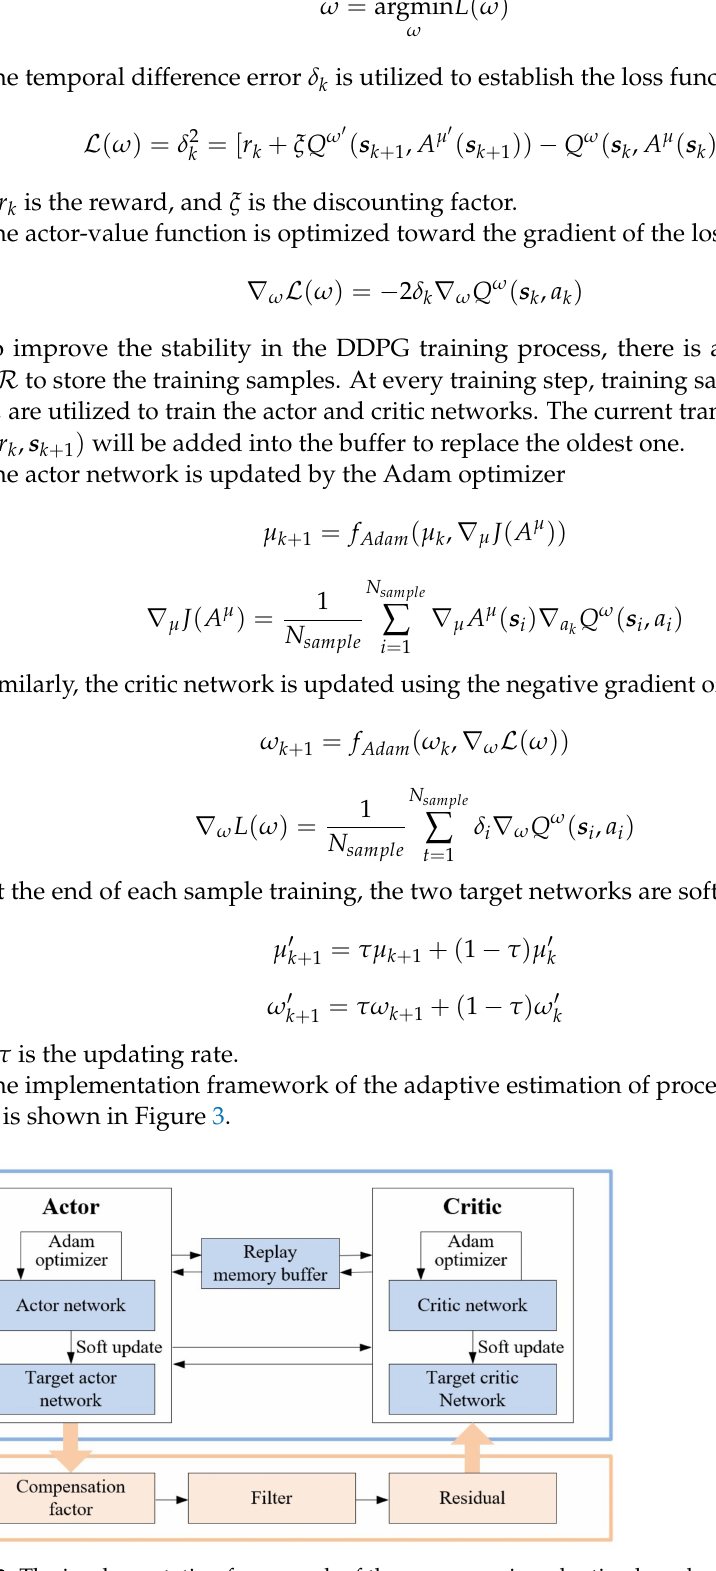
Figure 3. The implementation framework of the process noise adaption based on